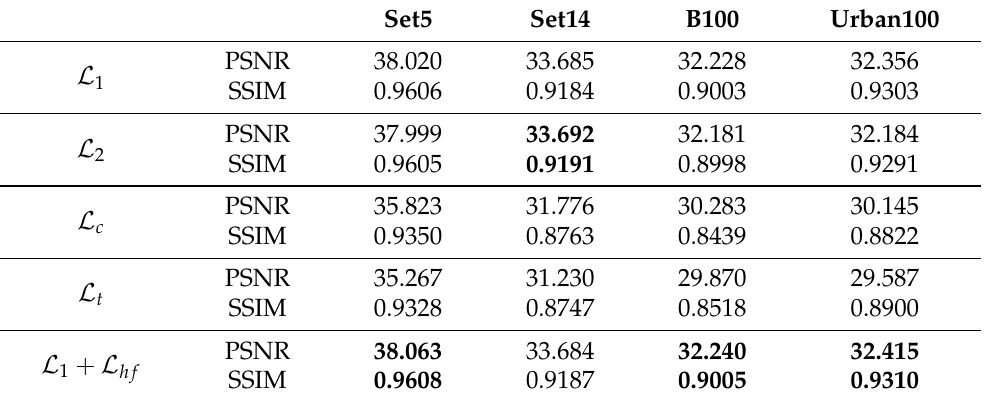
Table 2. Performance of different loss functions. Best results are bolded ( × 2 SR).